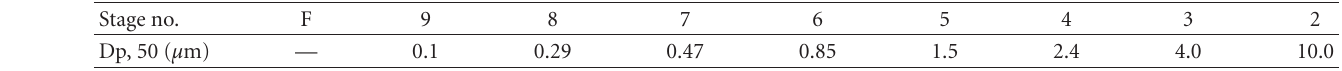
Table 2: Particle size cuto ff s of cascade impactor a .